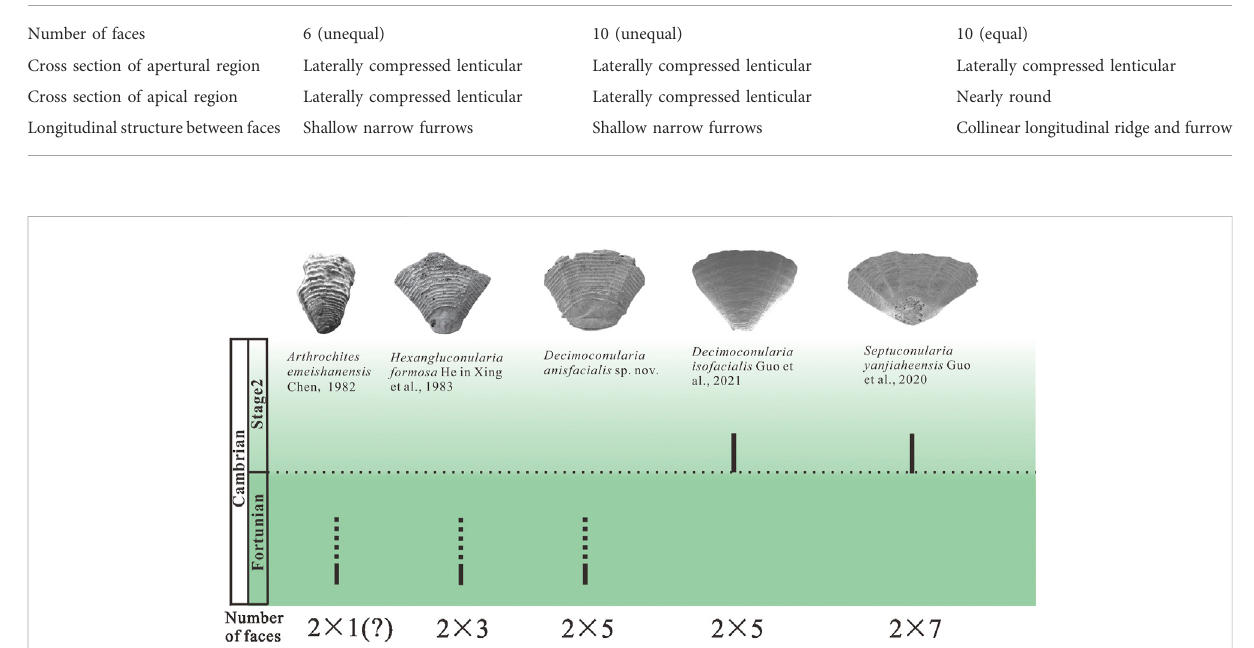
FIGURE 5 Stratigraphical distribution and face variation of Hexangulaconulariids in South China. The image of Arthrochites emeishanensis is modi fi ed from Figure 12 in Conway Morris and Chen (1992); Hexangluconularia formosa is modi fi ed from Figure 1 in Van Iten et al. (2010); Decimoconularia anisfacialis sp. nov. is specimen KP-45-1; Decimoconularia isofacialis and Septuconularia yanjiaheensis are modi fi ed from Figure 1in Guo et al. (2021a) and Figure 2 in Guo et al. (2020a),